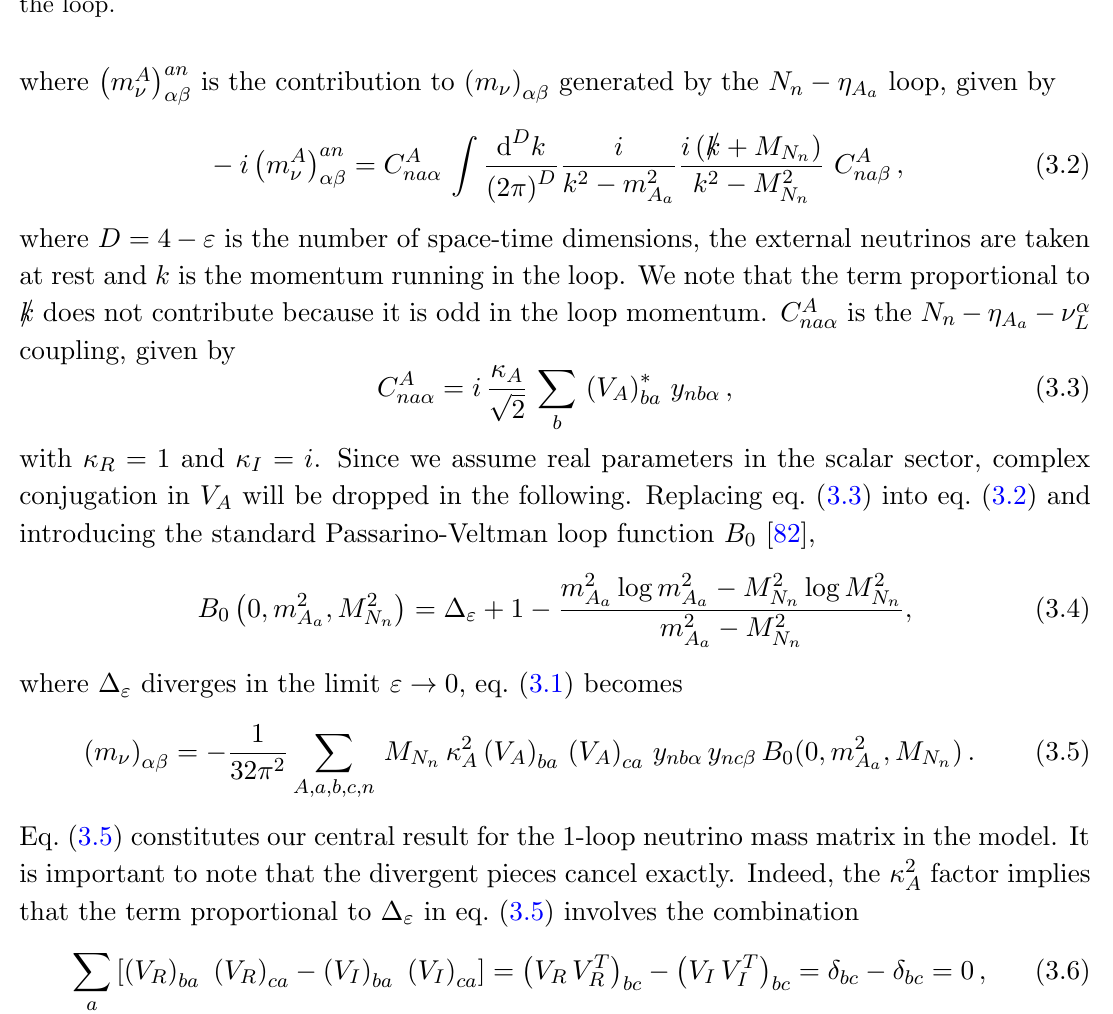
Figure 1 . Neutrino mass generation. To the left, Feynman diagram with gauge eigenstates. To the right, the analogous Feynman diagram with the physical mass eigenstates that propagate in the